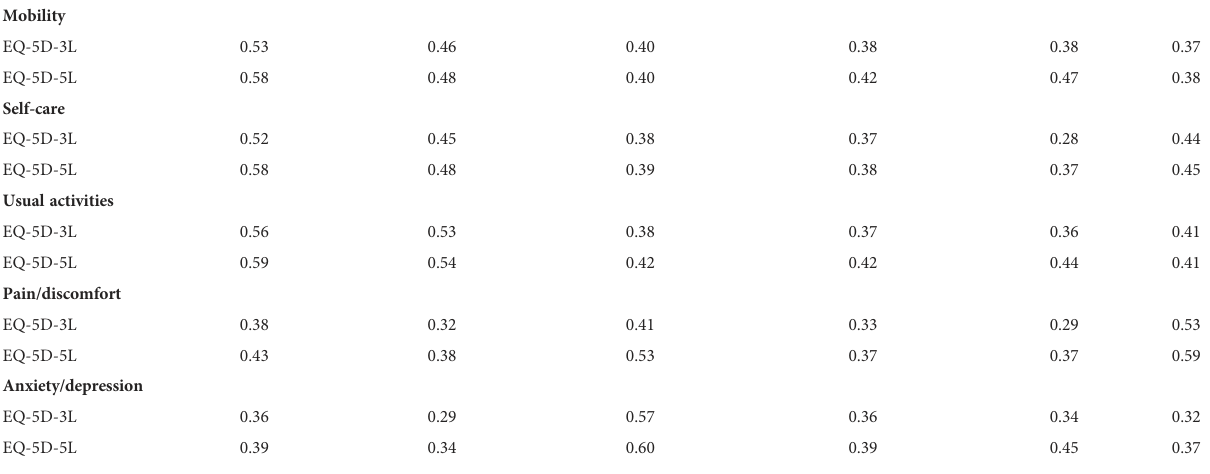
TABLE 5 Convergent validity of the 3L and 5L with QLQ-C30 scales.